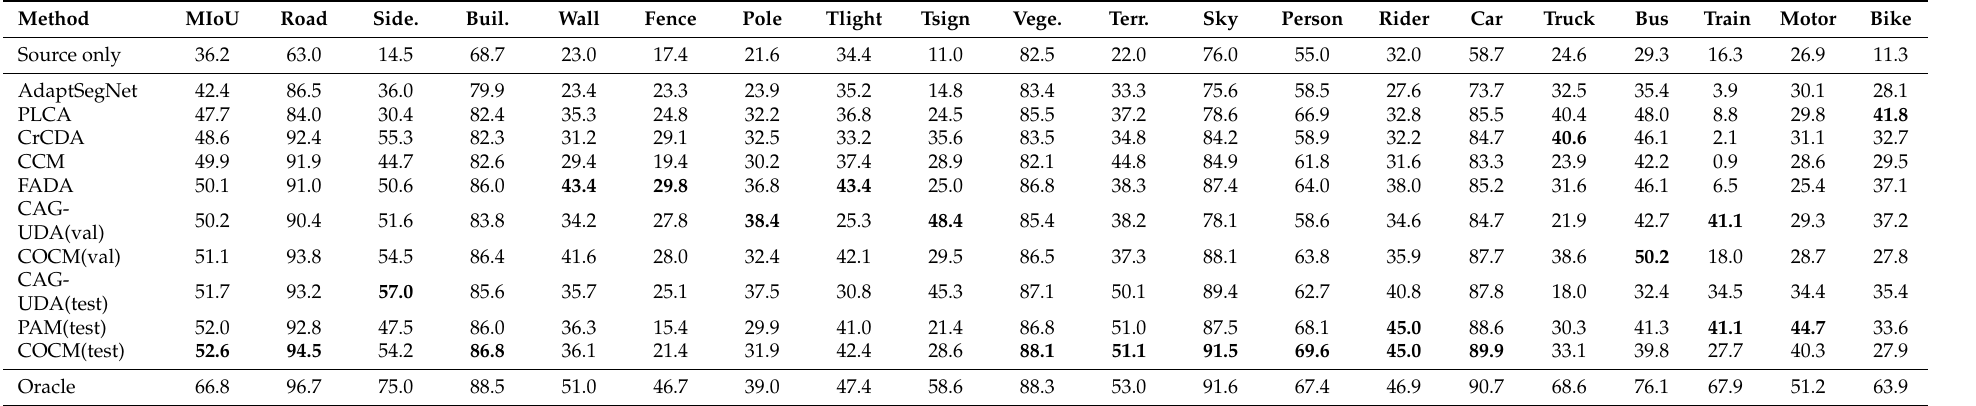
Table 1. Quantitative comparison on GTA5 → cityscapes